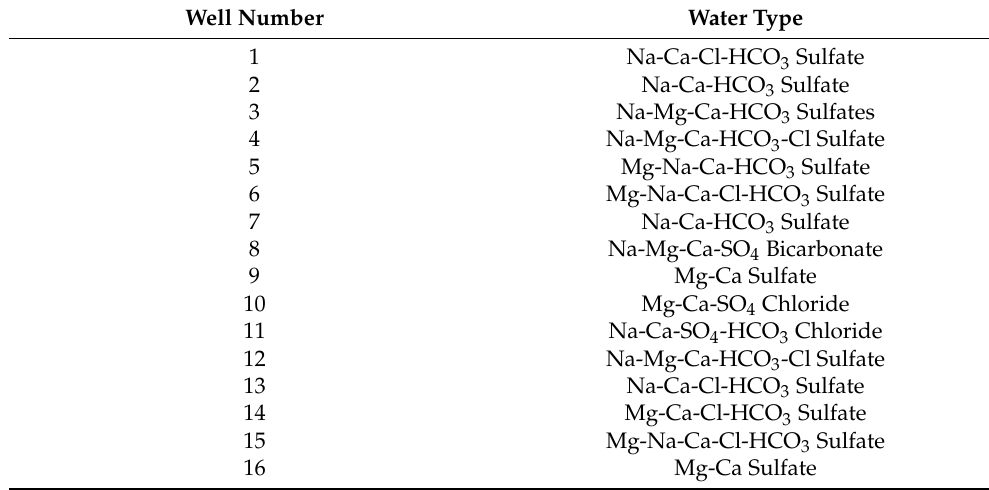
Table 9. Water type of the water well